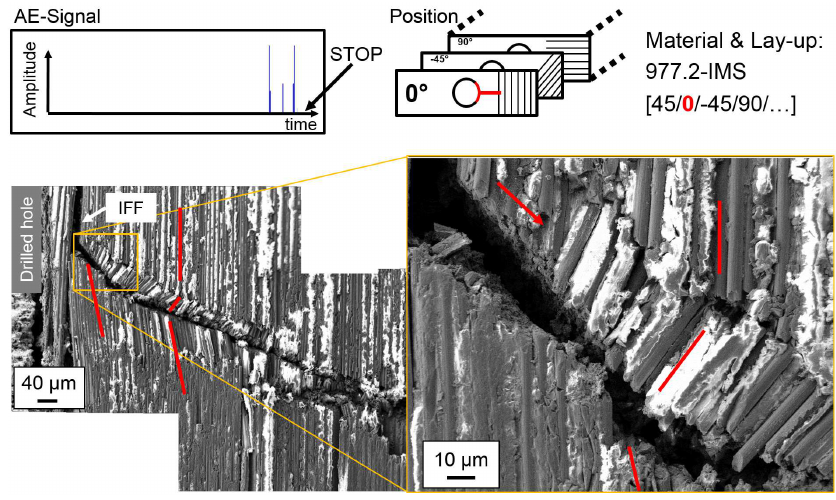
Figure 10. Damage propagation in the outer 0°-layer at the hole in a representative 977-2-IMS